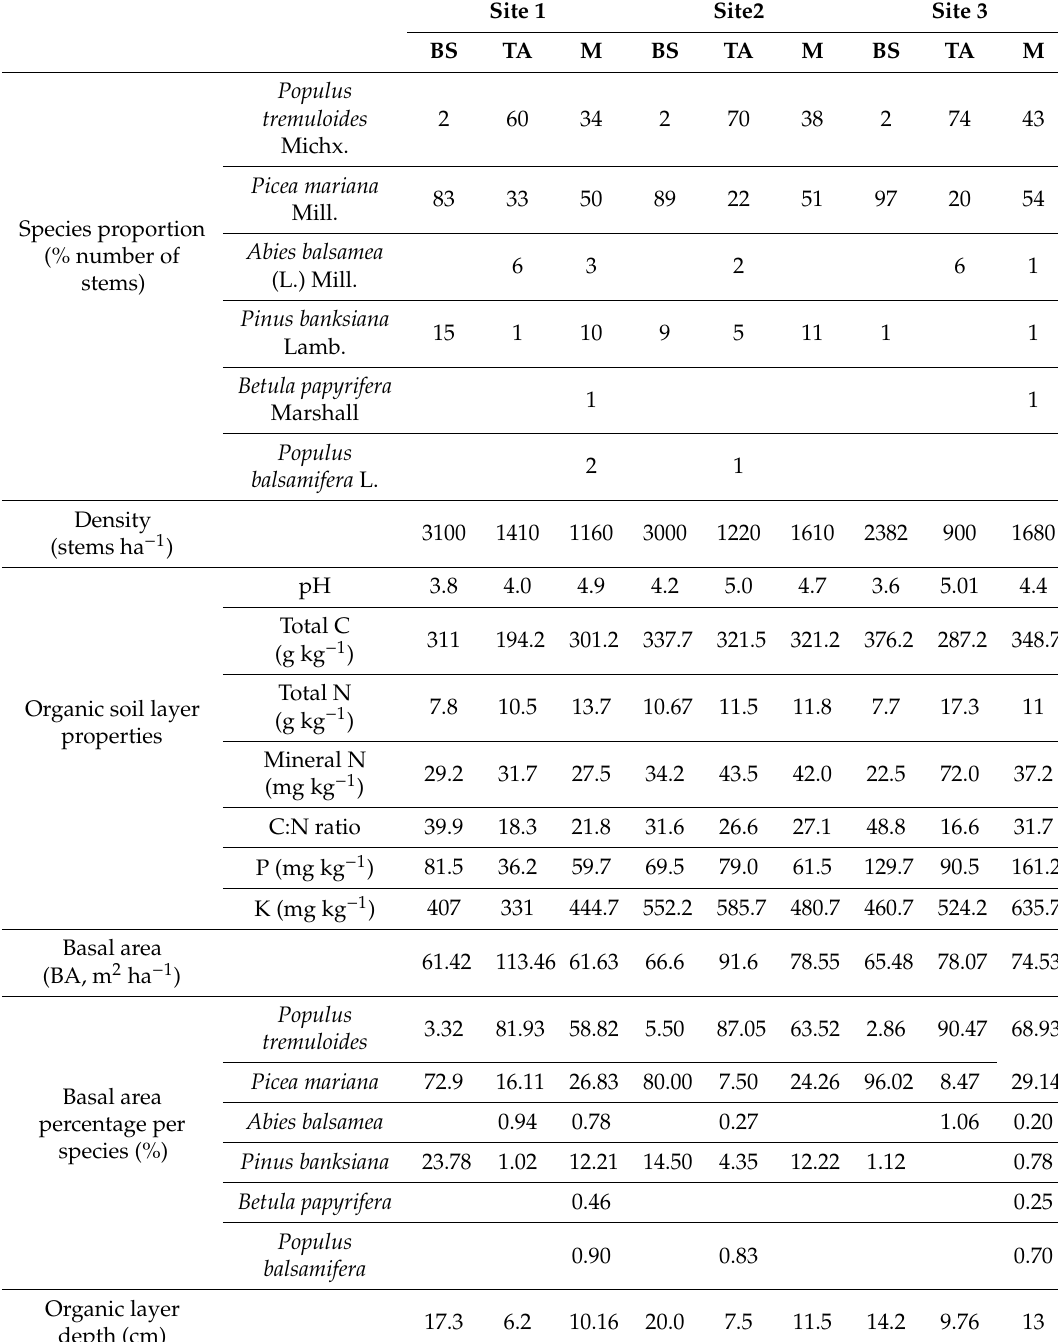
Table 1. Characteristics of sampled stands. BS, TA, and M refer to pure spruce, pure aspen, and mixed stands,